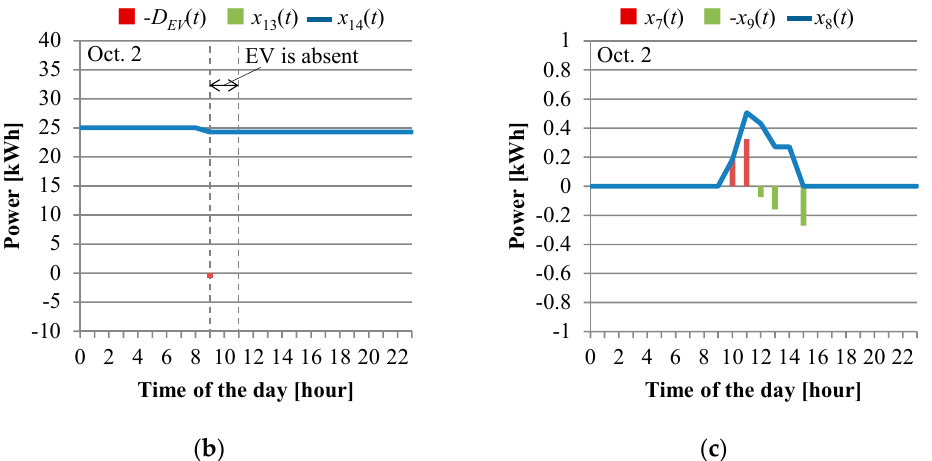
Figure 11. Optimized energy flow in case 3 on the day with small amount of PV power generation ( a ) residential supply-demand balance, ( b ) operation schedule of EV battery, and ( c ) operation schedule of SB.